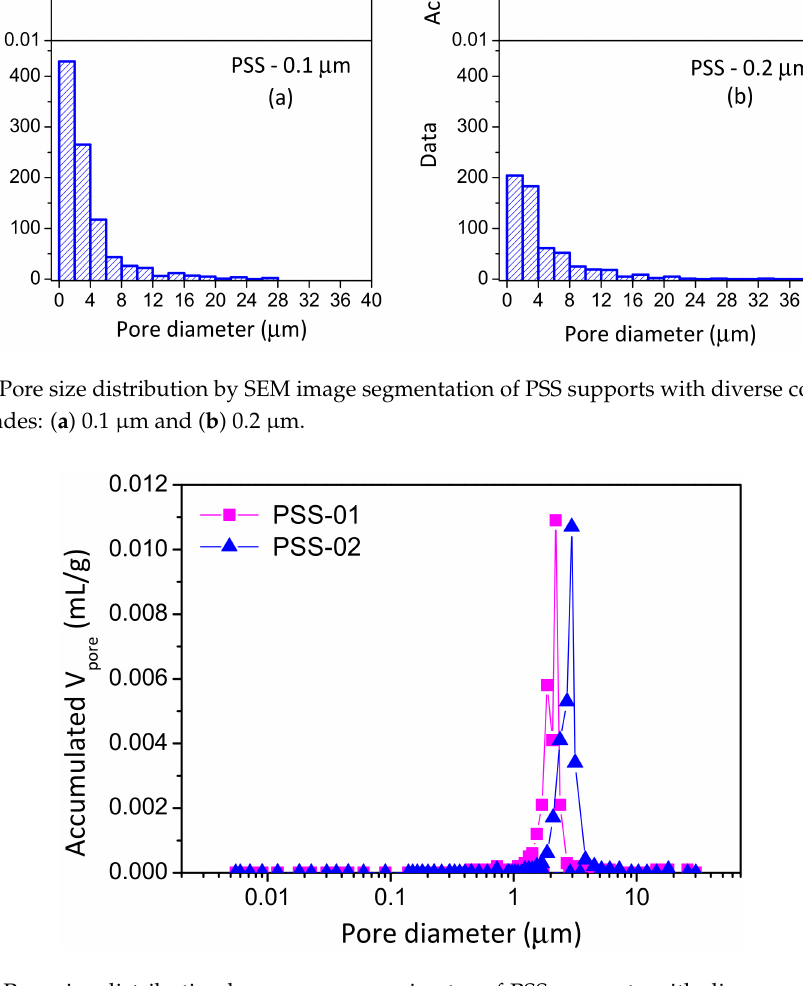
Figure 3. Pore size distribution by mercury porosimetry of PSS supports with diverse commercial grades: 0.1 µ m and 0.2 µ